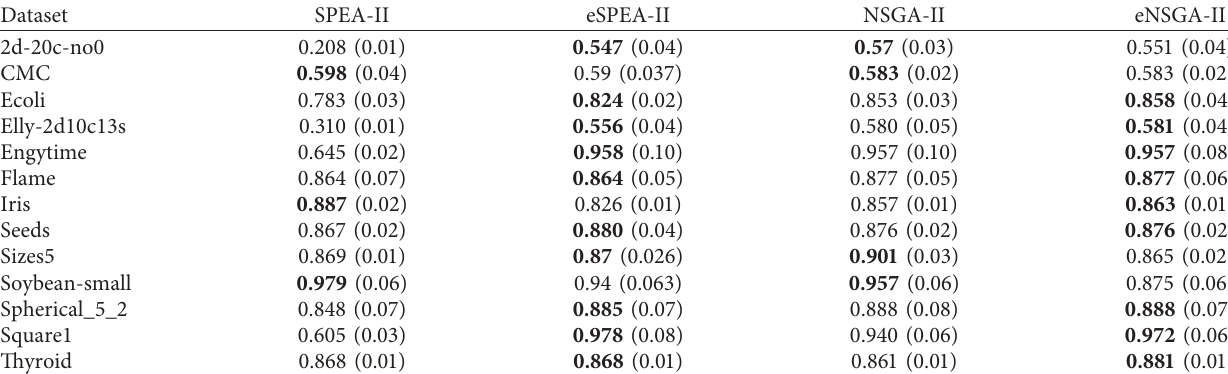
Table 4: The average and standard deviation a of the obtained F -measure obtained by the competing algorithms. Dataset